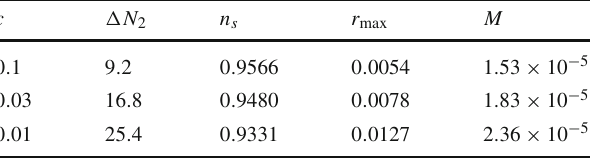
Table 3 The values of (cid:17) N 2 , n s , r max and M (in the Planck units) for the parameters (45) with b = 1 ,λ = 0